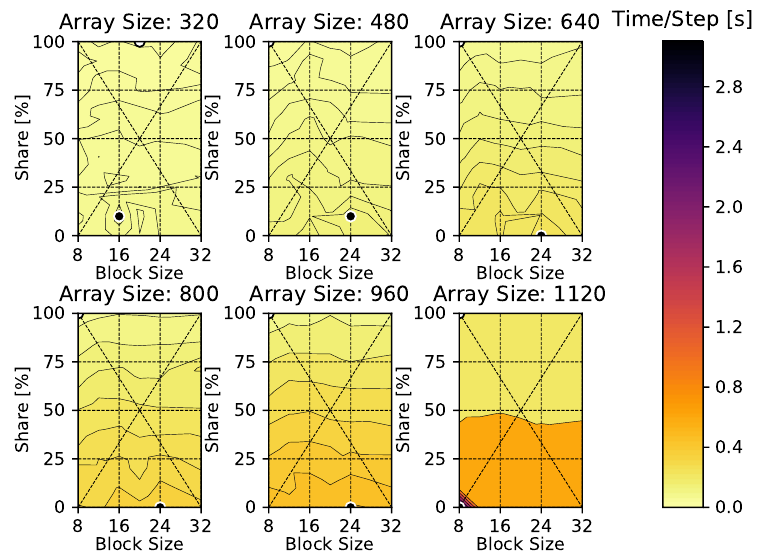
represents the worst case and a white dot with a black border represents the best case in all of the contours.